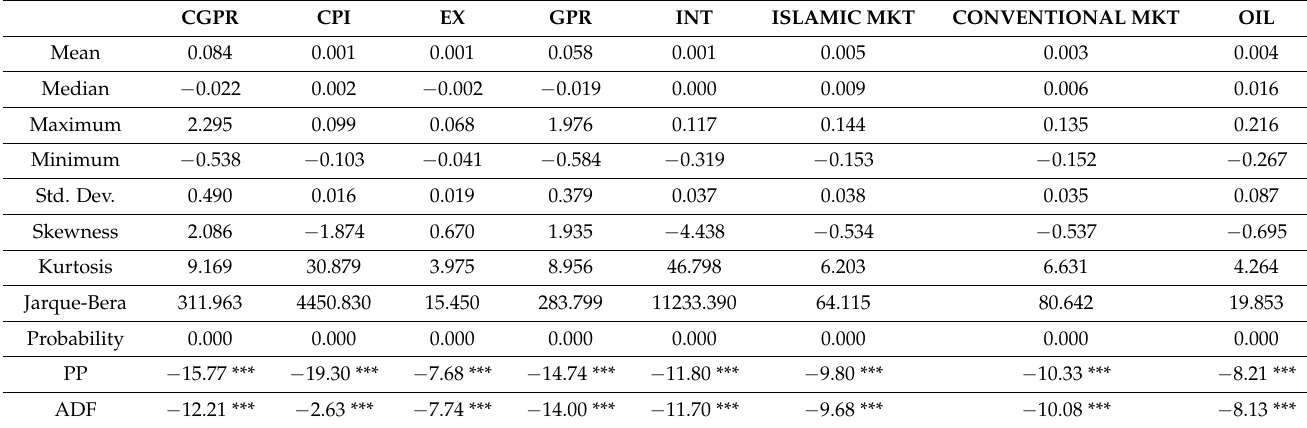
Table 1. Results of Preliminary Test.